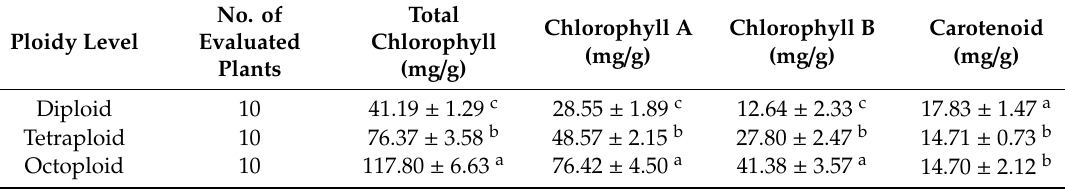
Table 5. Content of leaf pigments in diploid, tetraploid, and octoploid R. fortunei.